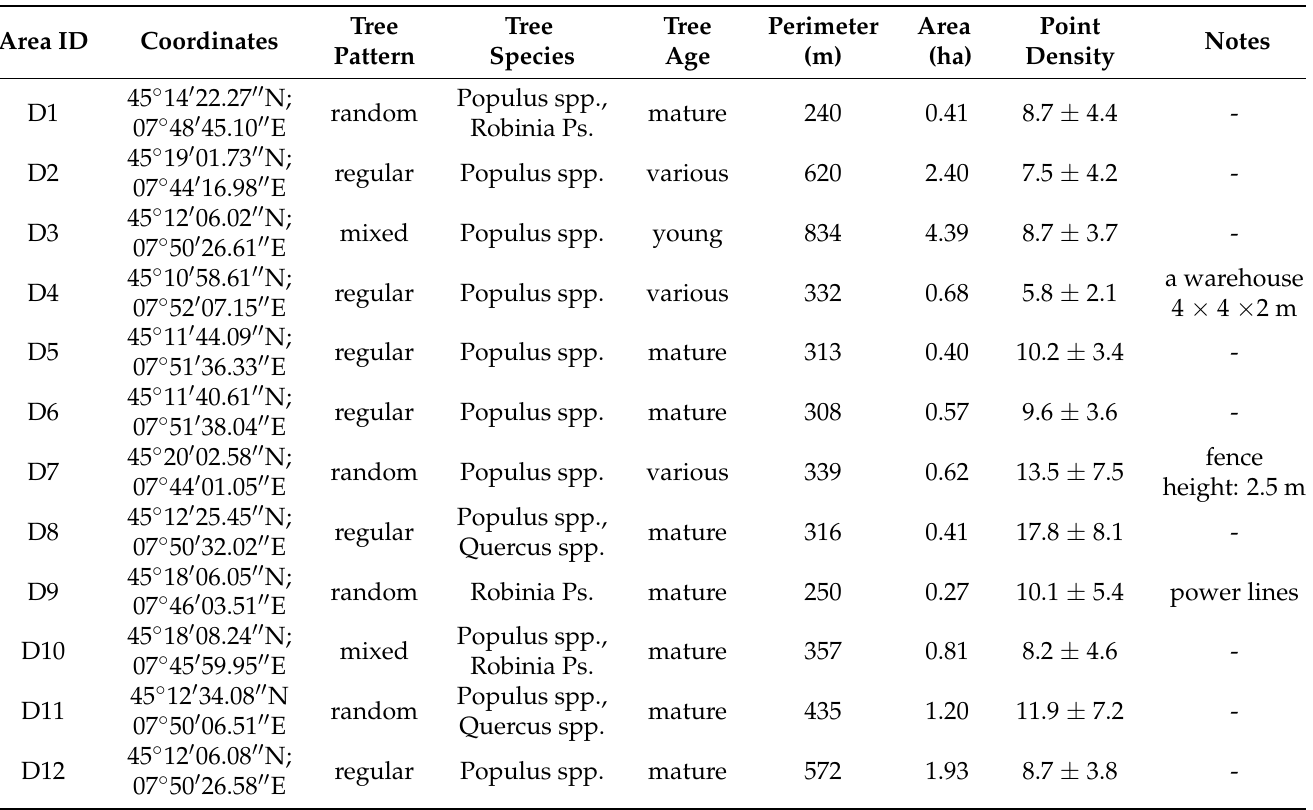
Table 1. Main features of the twelve study areas. The coordinates refer to the centroid of the area according to the reference system EPSG:25832. The tree count and information derive from the field survey carried out on February 2019. Area ID